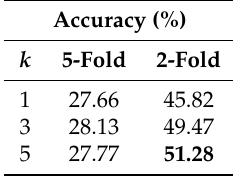
Table 4. Average accuracy of confusion matrix for different k (MATLAB